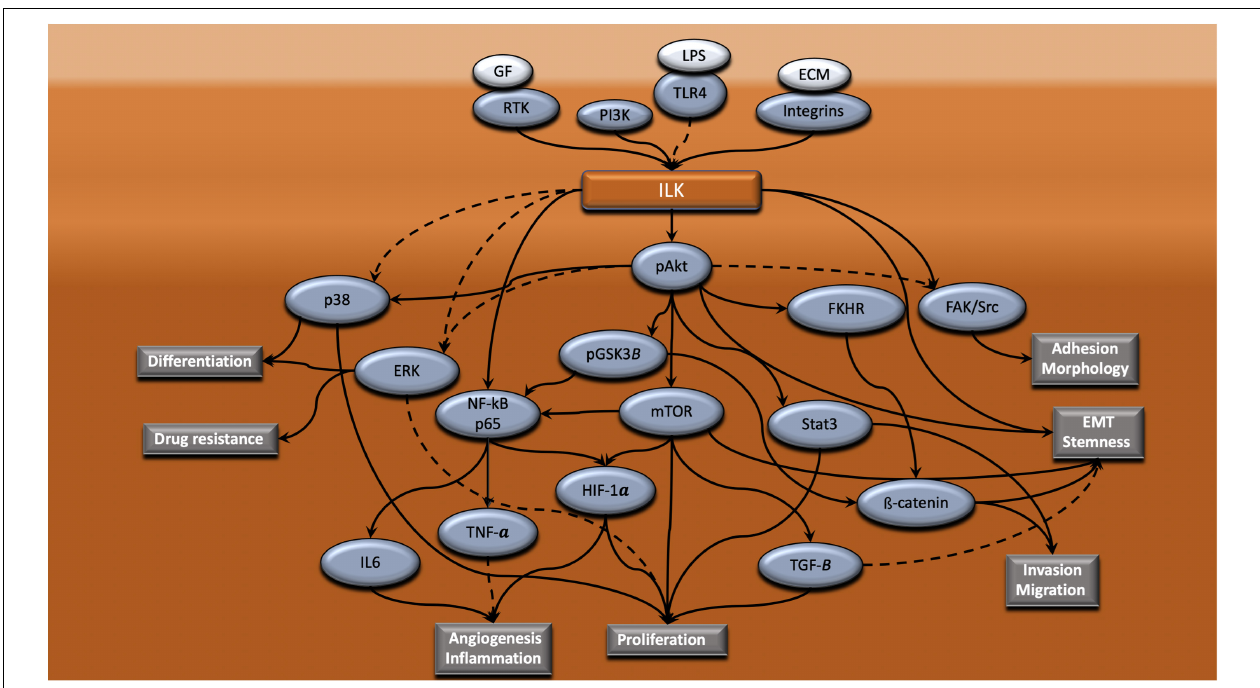
FIGURE 2 | ILK mediates regulation of different cellular processes in CRC via cross-talk with different intracellular signaling pathways. ILK is a central mediator of signaling cascades that regulate a range of cellular processes that are vital to the progression of CRC. ILK coordinates the connection of integrins, RTK and TLR4 with downstream signaling pathways, resulting in the regulation of processes such as adhesion, morphology, EMT, stemness, invasion, migration, proliferation, angiogenesis, inflammation, drug resistance and differentiation. Dotted lines indicate that this is yet to be shown in